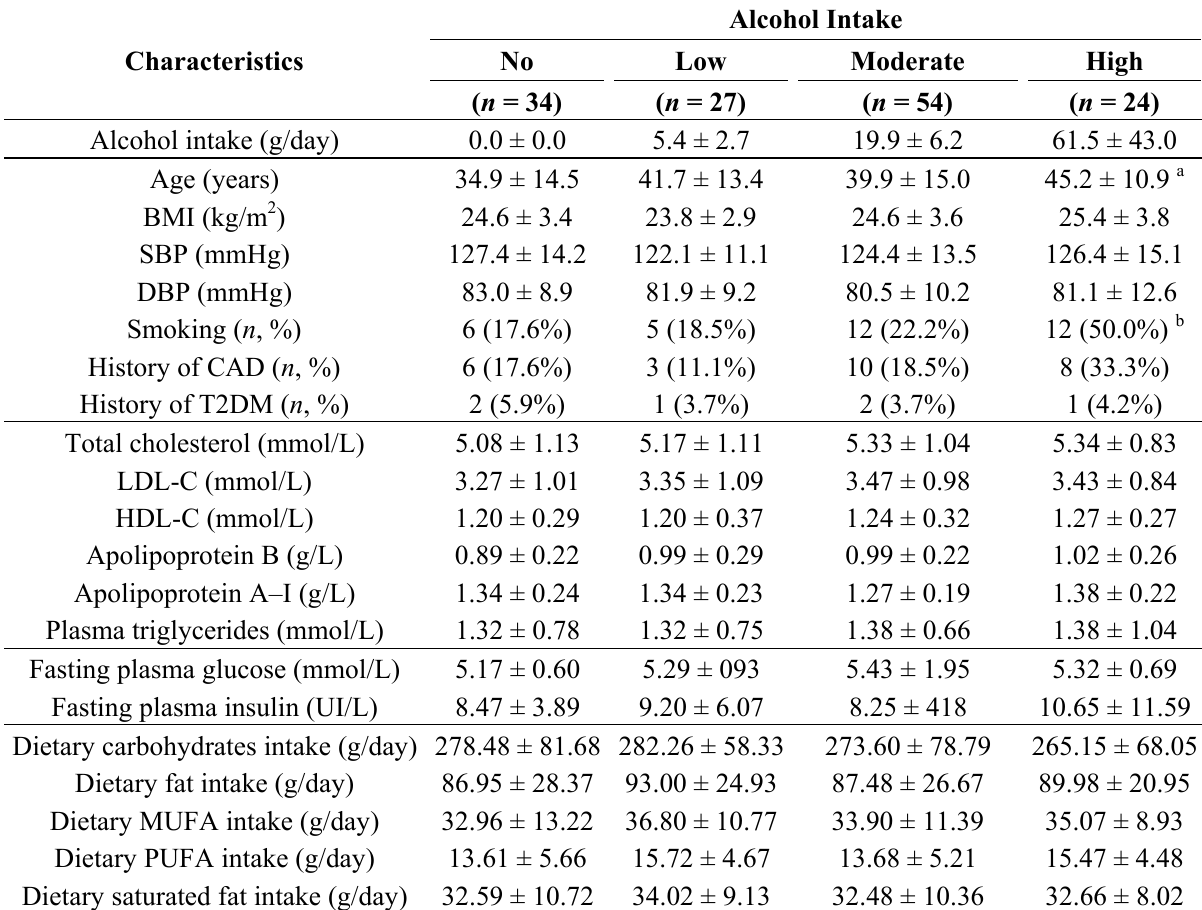
Table 2. Clinical, biochemical characteristics and dietary intake for male subjects depending on alcohol intake. Data are given as mean ± SD unless stated otherwise. * Adjusted for age, smoking habits and BMI; a Significantly different from corresponding value in no alcohol intake ( p < 0.05); b Significantly different from corresponding values of all other groups ( p < 0.05); c Significantly different from corresponding values of all other groups (adjusted p <